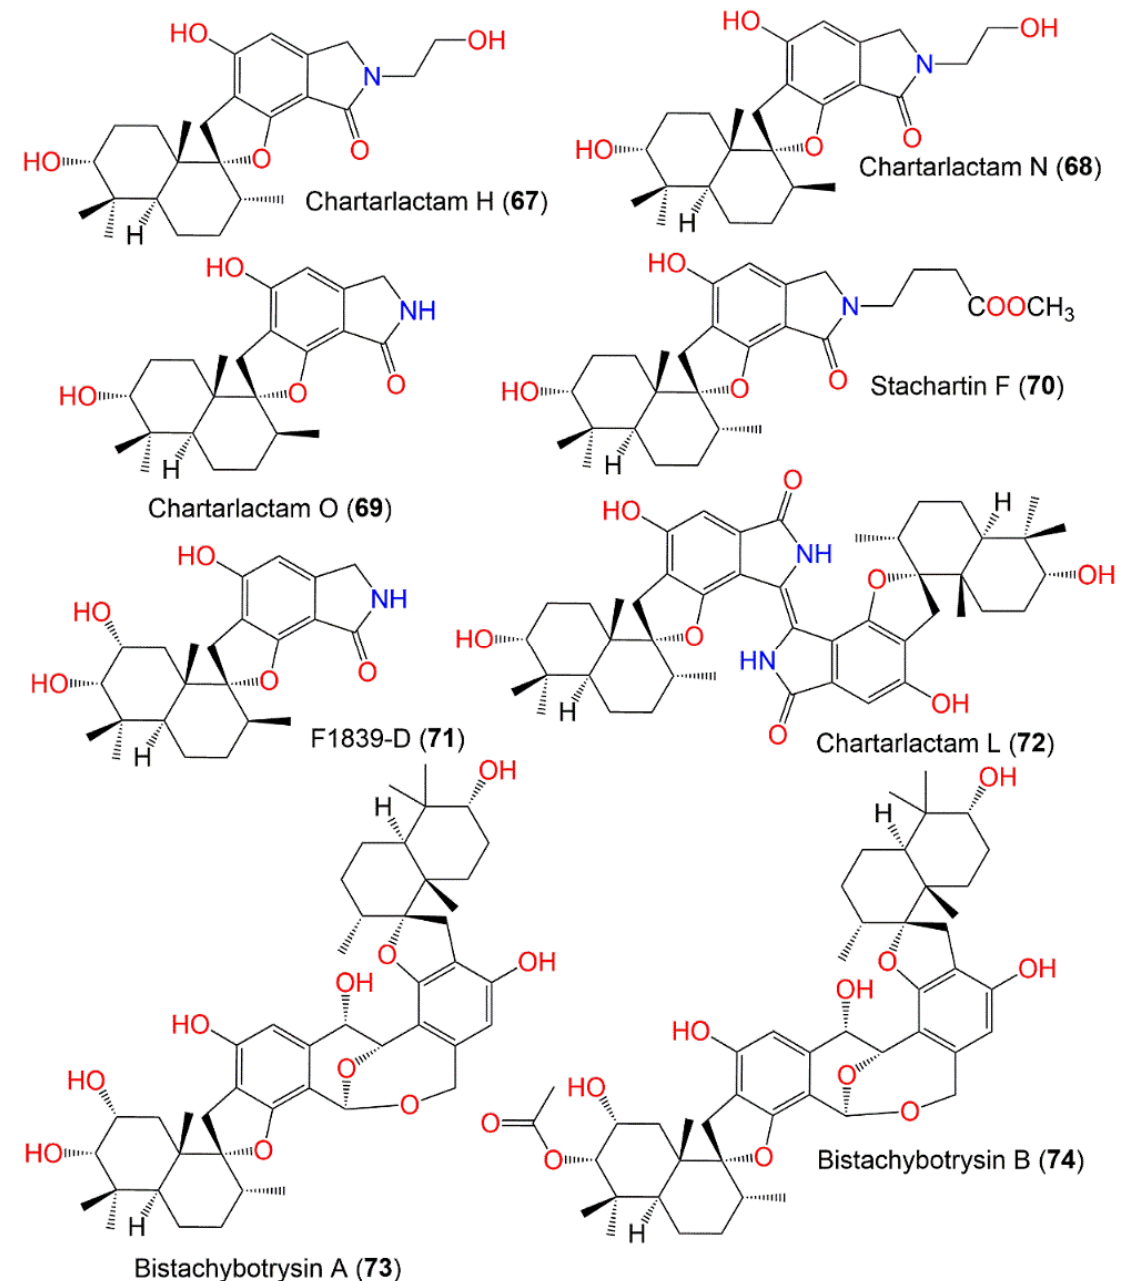
Figure 7. Structures of dimeric phenylspirodrimane derivatives ( 67 – 74 ) reported from S . chartarum . Their in vitro cytotoxic potential versus HCT-116 (colorectal carcinoma), NCI-H460 (lung carcinoma, BGC823 (gastric carcinoma), Daoy (medulloblastoma), and HepG2 (liver carcinoma) in the MTT assay was assessed. Compound 73 revealed powerful inhibitory capacity versus Daoy, HCT-116, and NCI- H460 (IC 50 S 2.8, 6.7, and 7.5 µ M, respectively), whereas 74 had potent activity versus Daoy, NCI-H460, and BGC823 (IC 50 S 4.2, 5.5, and 6.6 µ M, respectively). On the other side,